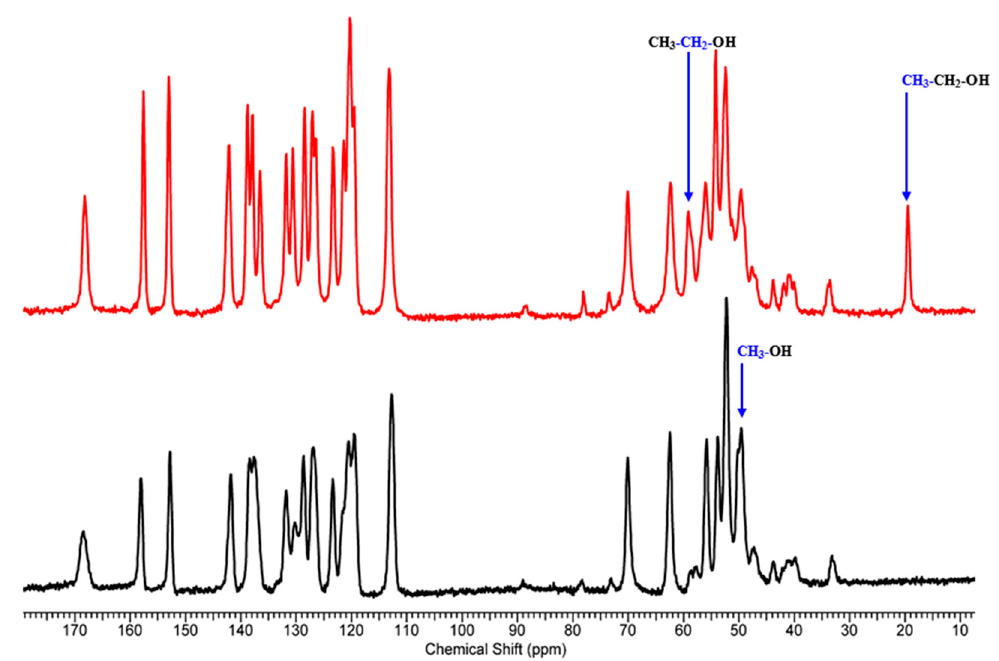
Figure 2. 13 C CP/MAS NMR spectra of 1-MeOH (black) and 1-EtOH (red) acquired with the contact time of 4 ms.